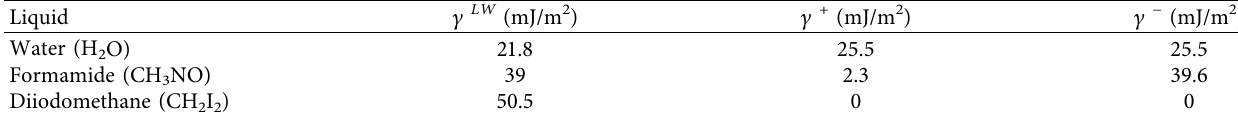
∗ French food composition table Ciqual [23] ANSES, the French agency for food, environmental, and occupational health safety. ∗∗ USDA Food Composition Databases [24], United States Department of Agriculture, Agricultural Research Service. Table 2: Surface tension properties of pure liquids used to measure contact angles